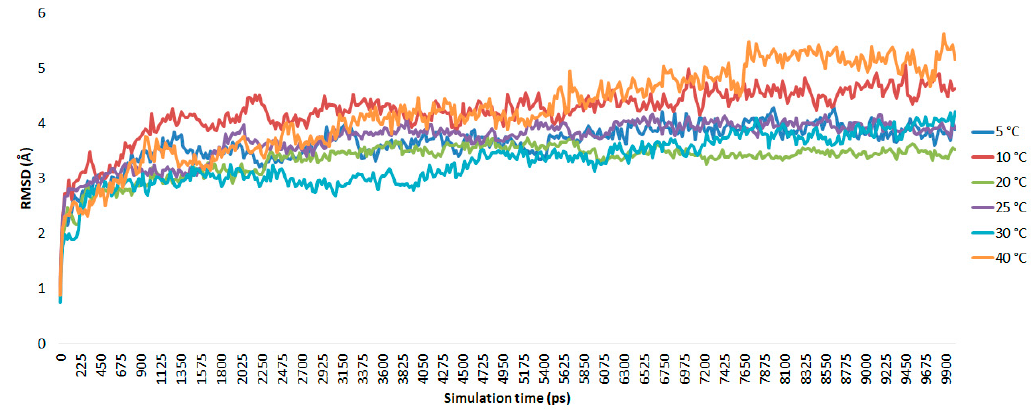
Figure 2. Root mean square deviation (RMSd) of AMS8 atoms as a function of time, simulated in the Triton X-100/toluene micelles at different temperatures.